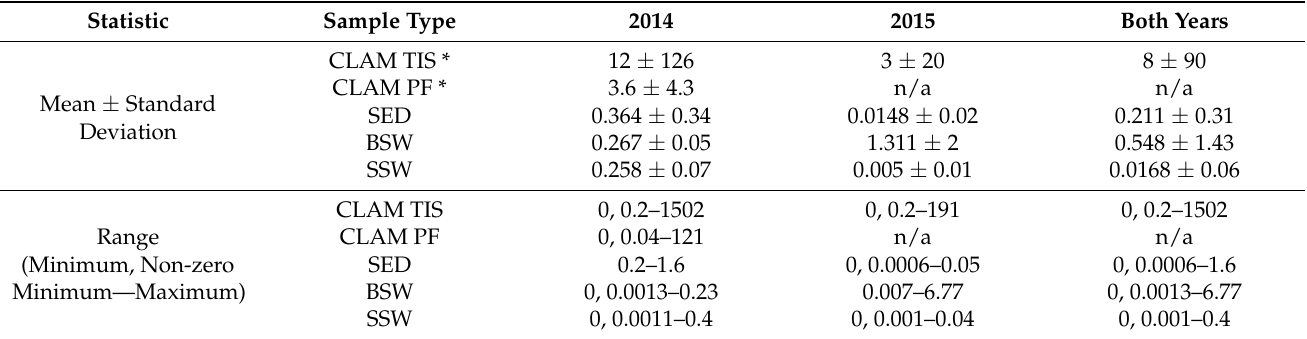
Table 2. Mean and range of M. quahogii (QPX) concentration converted to theoretical cellular concen- tration (cells/mg tissue, sediment or mL pallial fluid, seawater) from gene copy number based on a conversion factor of 440 copies/mononucleated M. quahogii cell. CLAM TIS, clam tissue samples; CLAM PF, clam pallial fluid